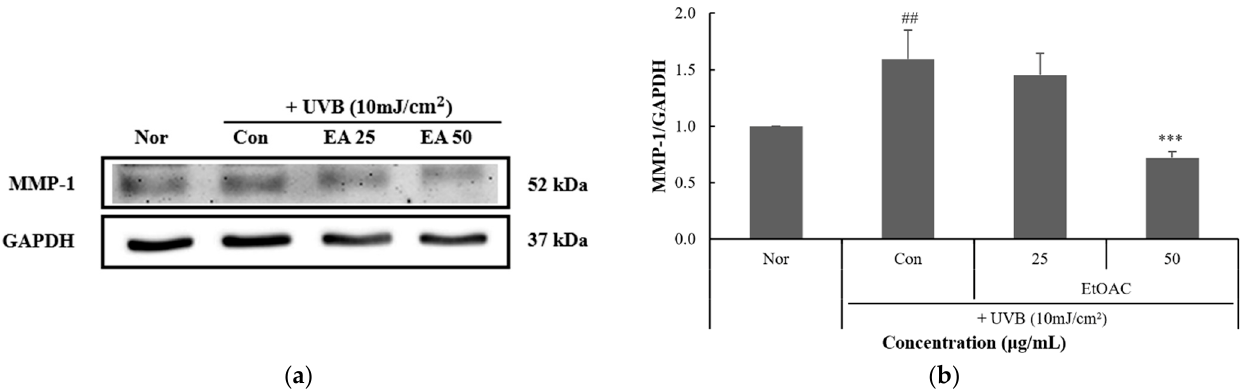
Figure 6. ( a ) Effect of P. thunbergiana L. EtOAc fraction on expression of MMP-1 in HaCaT cells. ( b ) Band intensity compared to the control (GAPDH) was determined using TotalLab 1D software. The results are expressed as the mean ± SD from three independent experiments. ## p < 0.01 compared with the normal control; *** p < 0.001 compared with the control.